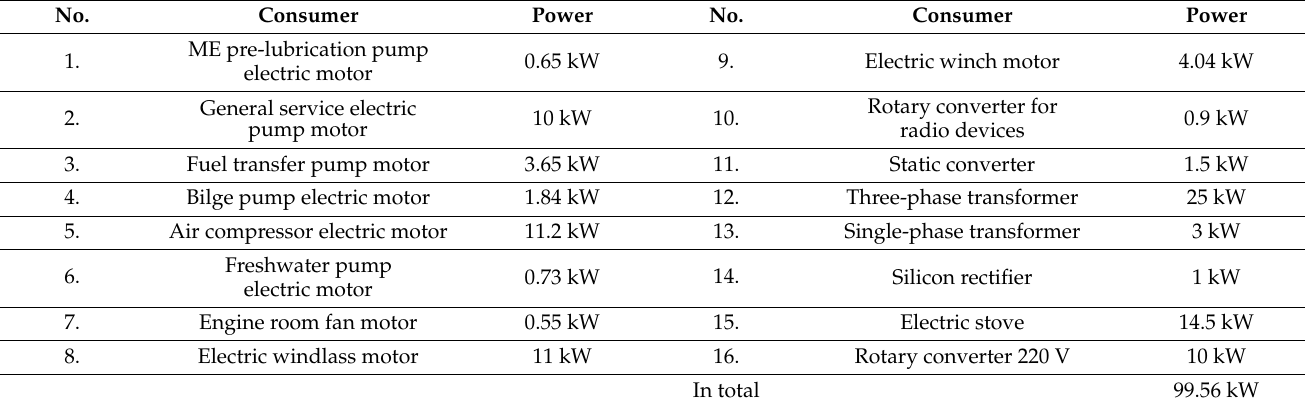
Table 2. Electricity balance